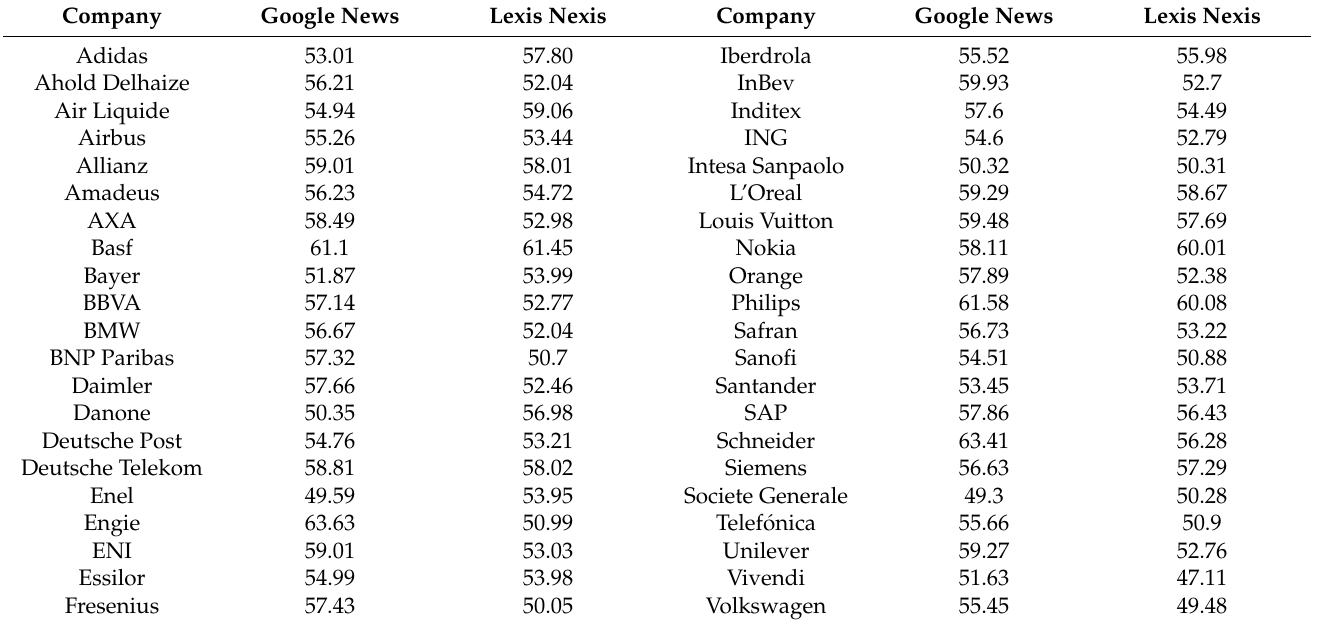
Table 2. Legitimacy Results of Google News vs. Lexis Nexis.